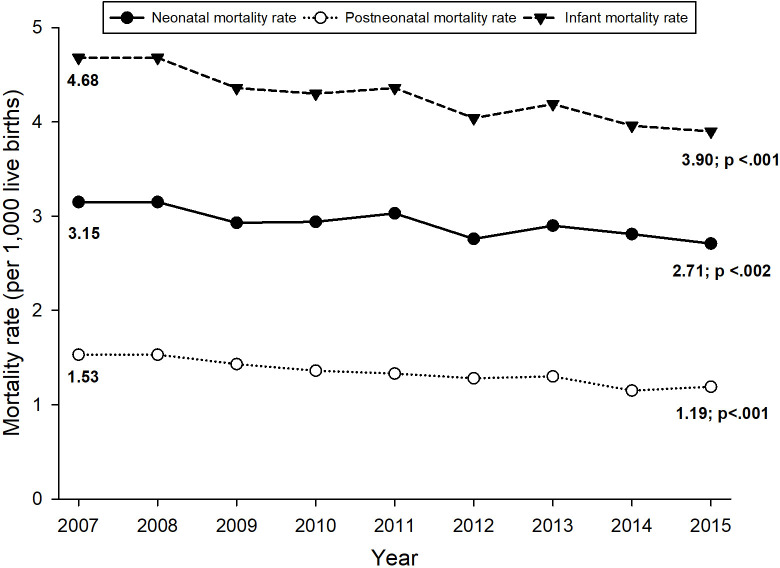
Infant, neonatal, and postneonatal mortalities (per 1,000 live births) for singleton births only in California for 2007 to 2015.p values indicate the significance of a linear regression. (Cochran-Armitage trend test also showed the declining trends in neonatal (p <0.001), postneonatal (p<0.001), and infant mortality rates (p<0.001) for singleton births from 2007 to 2015).